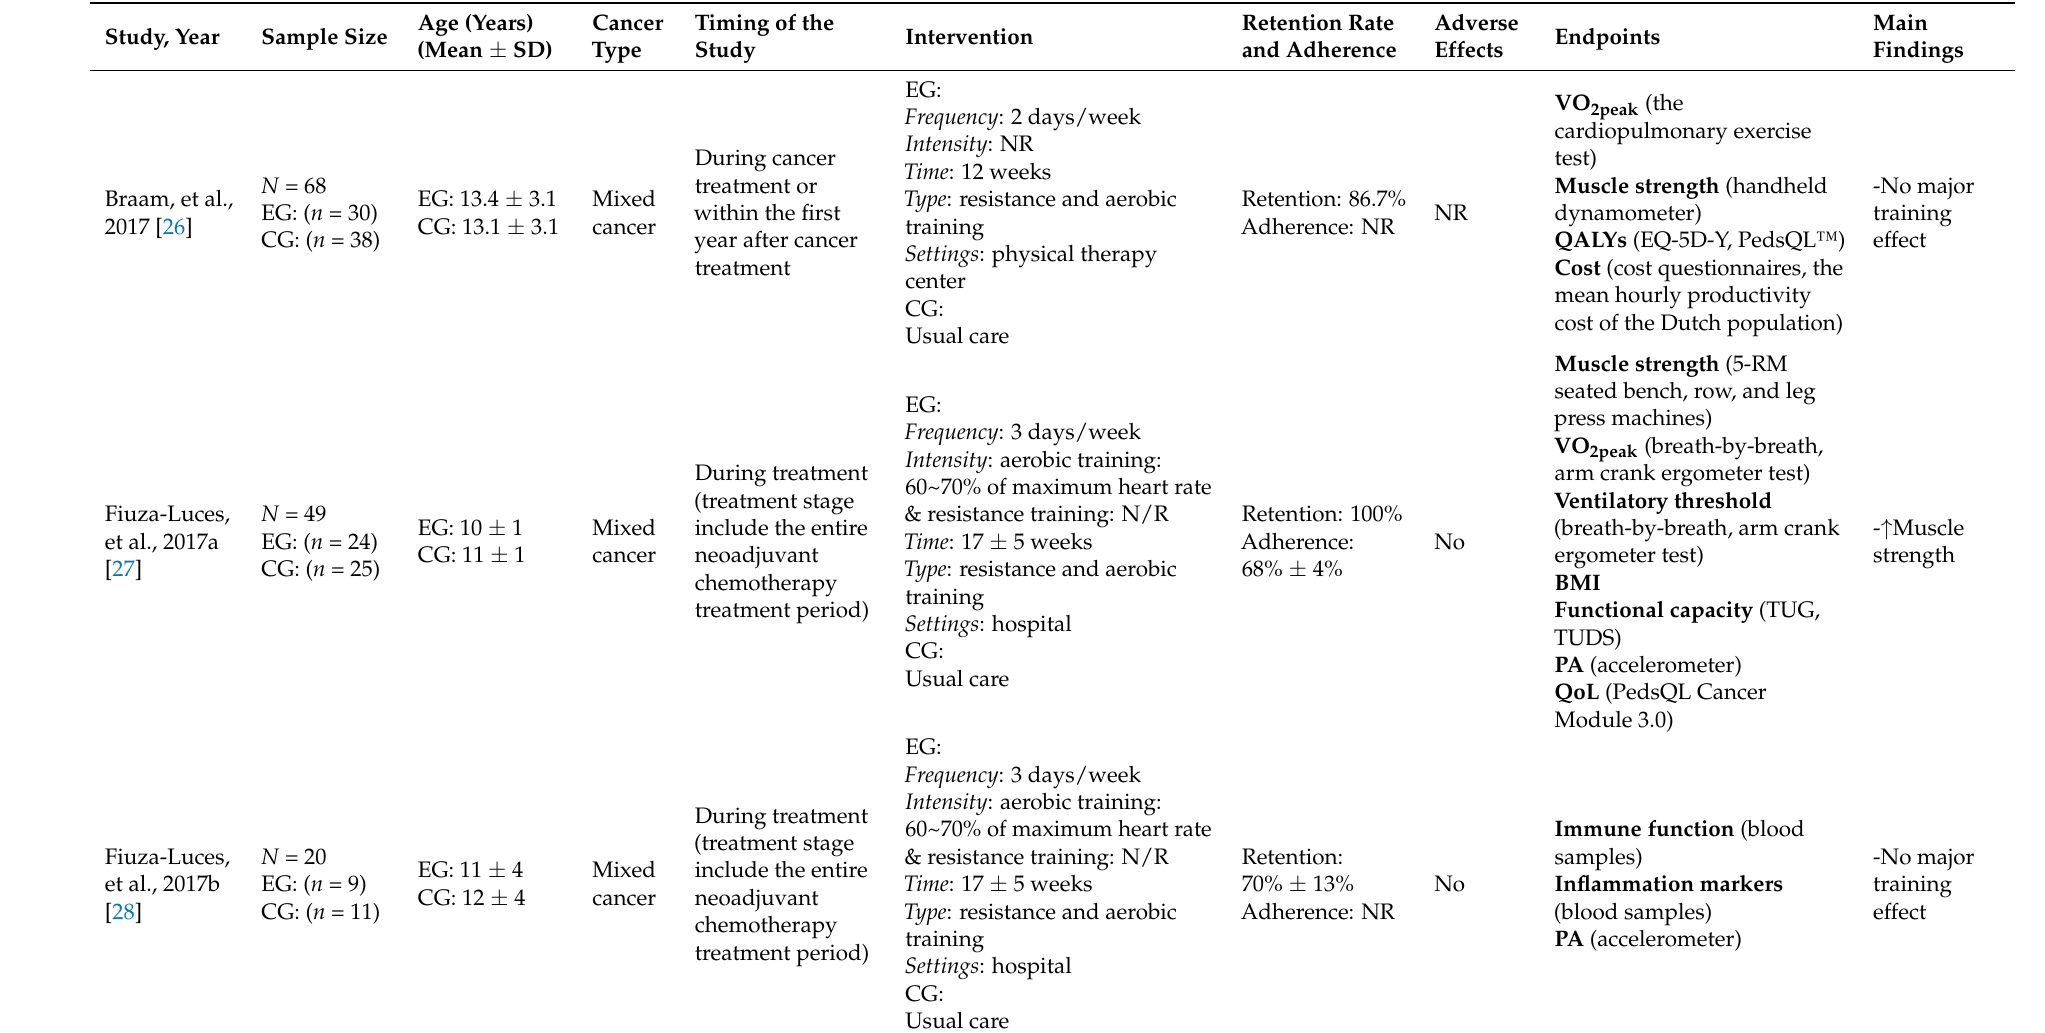
Table 1. Main characteristics of supervised exercise interventions for childhood cancer